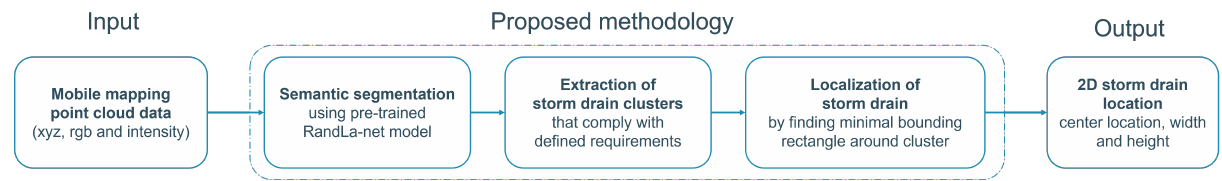
Figure 1. Schematic overview of the proposed workflow. The mobile mapping point cloud is segmented into different classes of which the hardscape class is used to extract storm drain clusters. In each cluster, the storm drain location and size are determined by finding the minimal bounding rectangle of the cluster